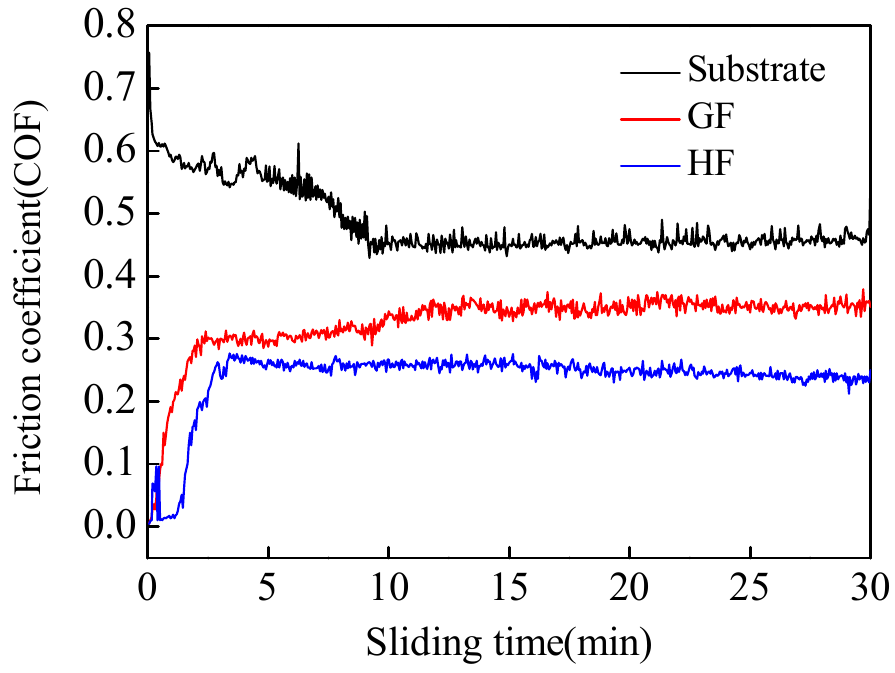
Figure 11. The friction coefficient curve of the substrate, GF and HF coating.